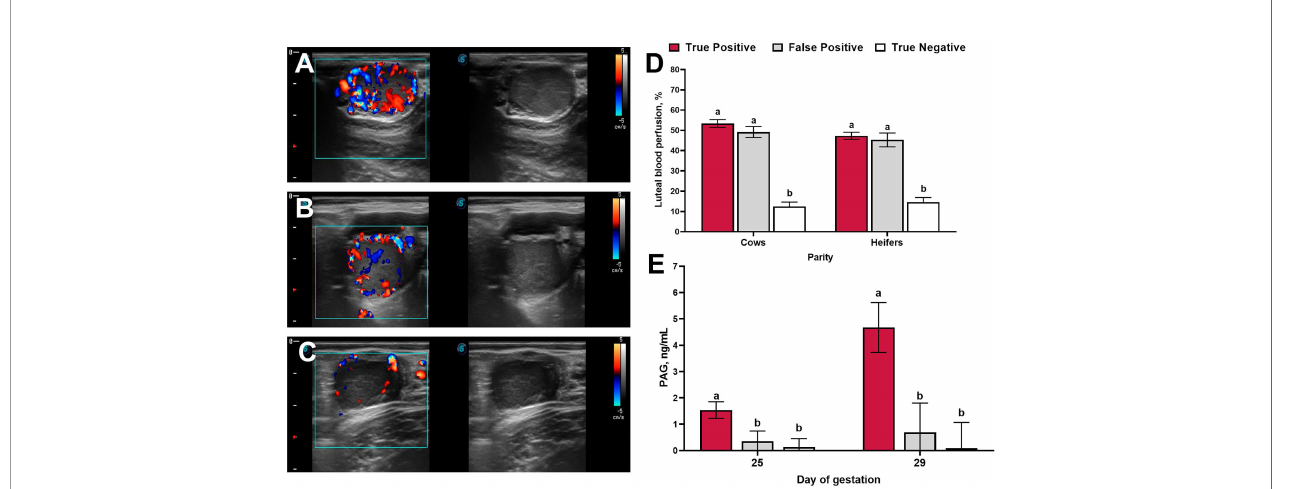
FIGURE 1 | Representative ultrasound images of luteal blood perfusion collected on day 20 of gestation from beef cows classi fi ed as true-positive (A) , false-positive (B) , and true-negative (C) . (D) : Luteal blood perfusion on day 20 of gestation in cows ( n = 208) and heifers ( n = 178) with different pregnancy diagnosis results. (E) : Circulating concentrations of pregnancy associated glycoproteins (PAG) on days 25 and 29 of gestation according to pregnancy diagnosis results. Uncommon superscripts represent statistical differences in least-square means ( P ≤ 0.05). Adapted from Holton et al.